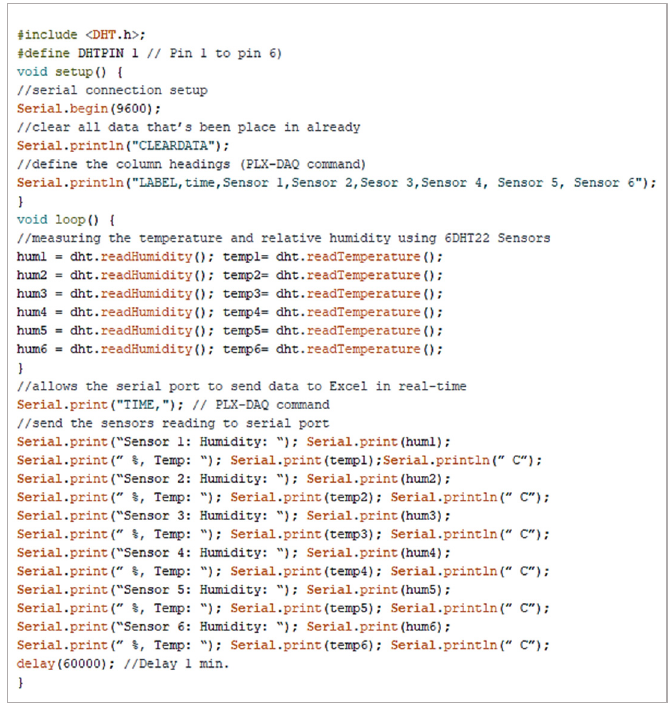
Figure 5. Screenshot of the program code used to acquire the temperature and RH measured data in real-time using six DHT22 sensors and send the measurements to a PLX-DAQ Spreadsheet.